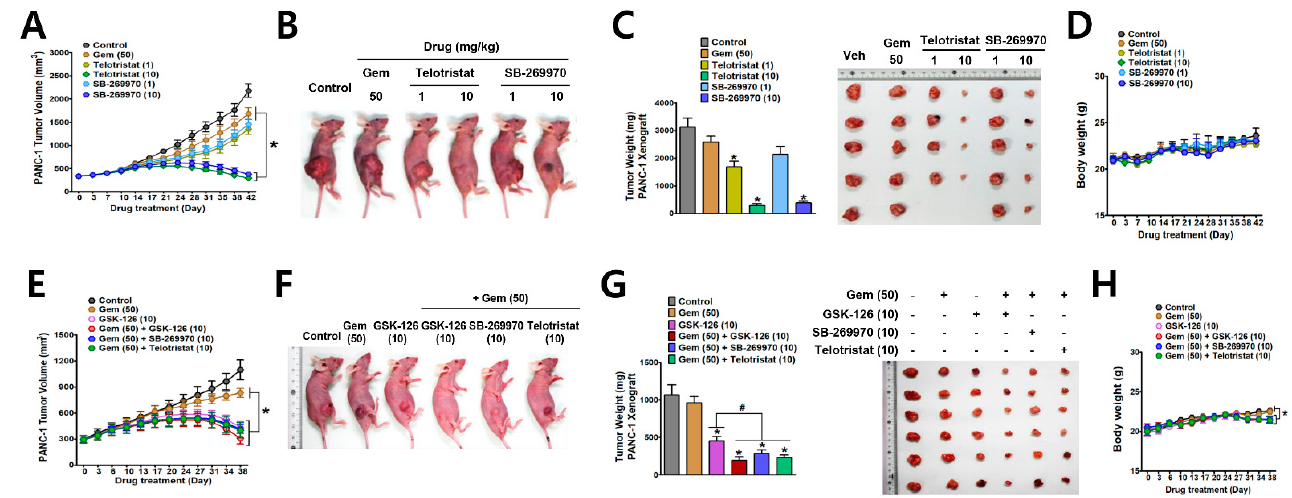
Figure 7. Anti-tumor activities of inhibitors of EZH2-TPH1-5-HT 7 axis in mouse tumor xenograft models with PANC-1 cells. ( A – D ) BALB/c nude mice xenografted with PANC-1 cells were administered i.p. with gemcitabine (50 mg/kg), telotristat (1 and 10 mg/kg), SB-269970 (1 and 10 mg/kg) for 42 days (6 days per week) ( n = 5). Tumor volume (mm 3 ) was measured twice a week ( A ). Representative images showing gross appearance of tumor in mice ( B ) and weight of excised tumor at the time of sacrifice ( C ). Mouse body weight during the drug administration period ( D ). * p < 0.05 compared to the vehicle-treated control. ( E – H ) In a separate set of mouse tumor models, mice were administered i.p. with drug alone (50 mg/kg gemcitabine or 10 mg/kg GSK-126) or gemcitabine plus drug (10 mg/kg of GSK-126, SB-269970, or telotristat) for 38 days ( n = 6). Tumor volume ( E ), gross appearance of tumor in mice ( F ), and tumor weight ( G ) at the time of sacrifice, and mouse body weight during the treatment period ( H ). * p < 0.05 compared to the vehicle-treated control. # p < 0.05 compared to GSK-126-treated